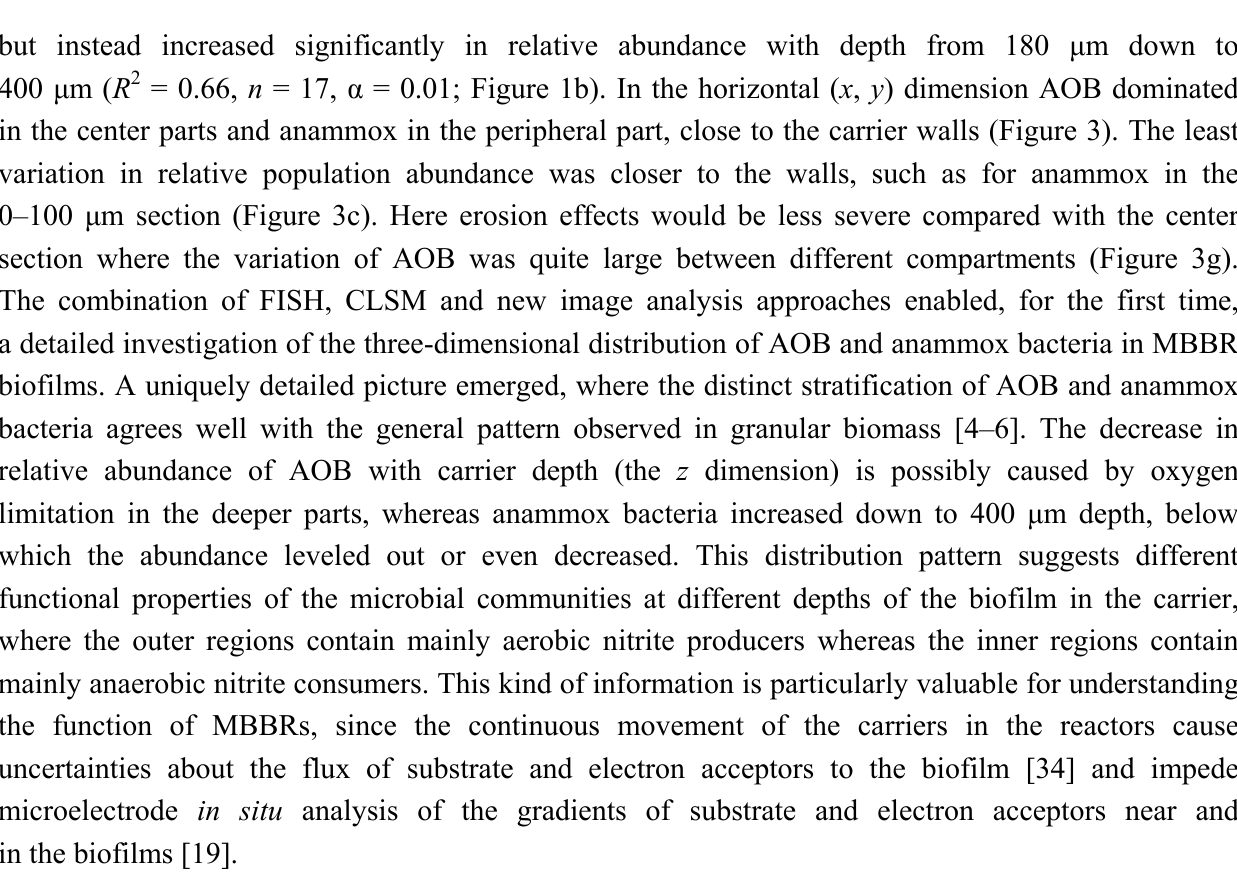
Figure 2. Assembled FISH “wall-to-wall” micrographs of biofilm from the biofilm